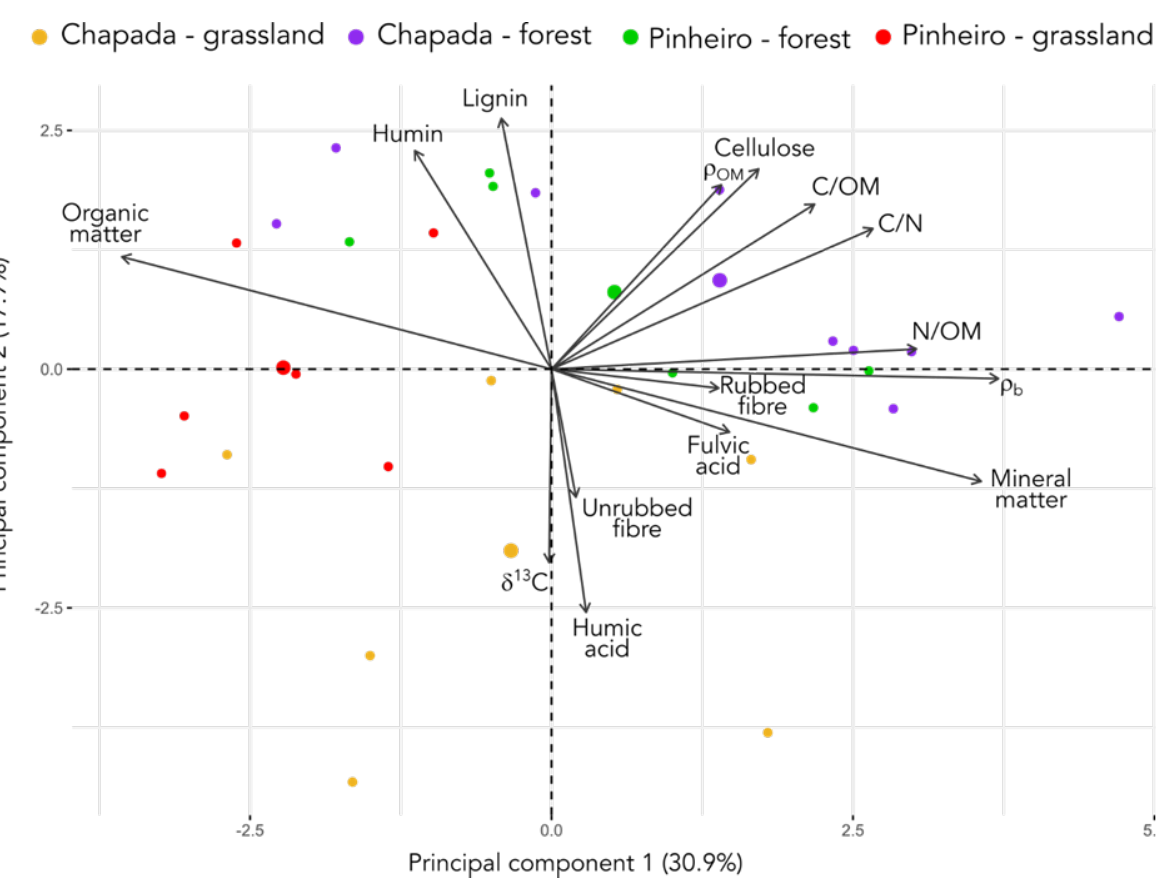
Figure 4. Biplot of the principal component analysis for soil and organic matter attributes from the studied peatlands (Pinheiro and Chapada) under grassland ( campo ) and forest ( capão ) vegetation. ρ ρ = organic matter bulk density; C/OM = carbon content in the organic matter; N/OM = nitrogen content OM in the organic matter.